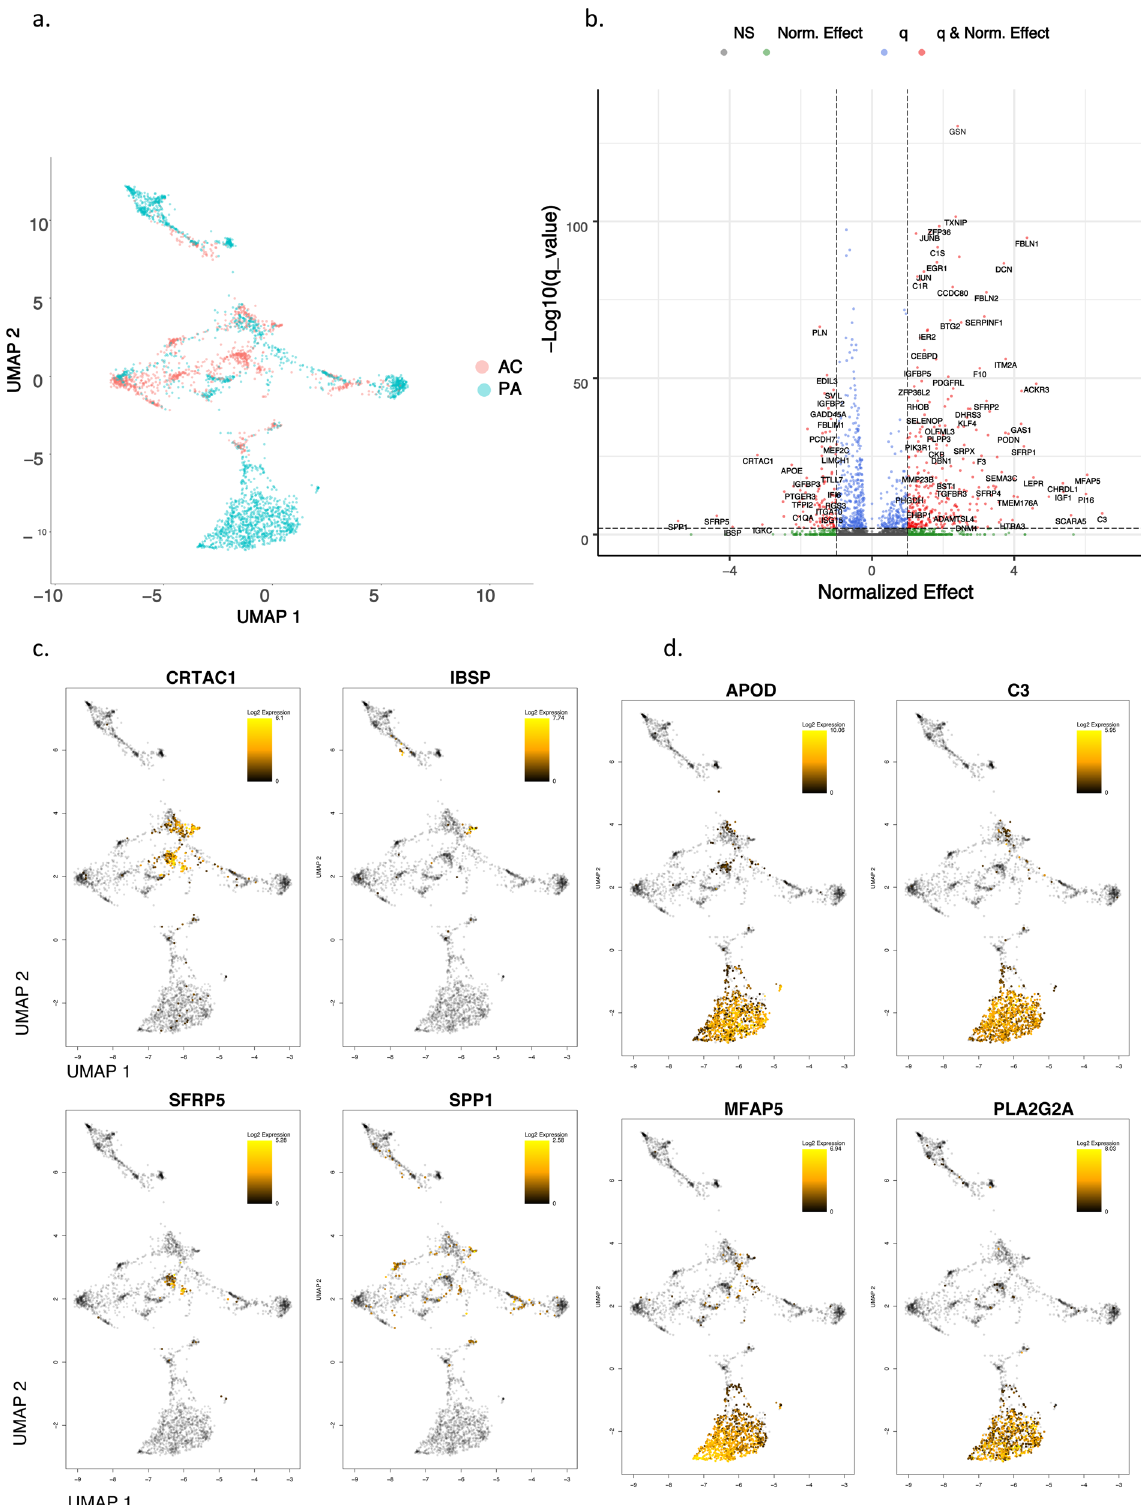
Fig. 2 Differential gene expression in VSMCs and ECs. a , e UMAP visualization of VSMCs ( a ) and ECs ( e ), separated by anatomic location. b , f Volcano plots of the top differentially expressed genes in VSMCs ( b ) and ECs ( f ). Dotted lines represented q -value 0.5 and < − 0.5 corresponding to PA and AC cells, respectively. c , d UMAP visualization of the top 4 upregulated genes in AC VSMCs ( c ), and PA VSMCs ( d ). Gray-colored cells indicate 0 expression of designated gene, while color bar gradient indicates lowest (black) to highest (yellow) gene expression level. g , h UMAP visualization of the top 4 upregulated genes in AC ECs ( g ), and PA ECs ( h ). Color scheme is similar to the above-described parameters. VSMCs = 3674 cells; ECs = 2764 cells. n = 3 for PA and AC